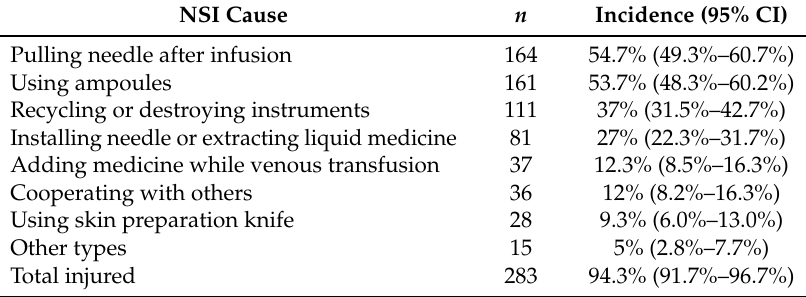
Table 3. NSI (Needle-stick and Sharps Injuries) reported for subjects ( n = 300).